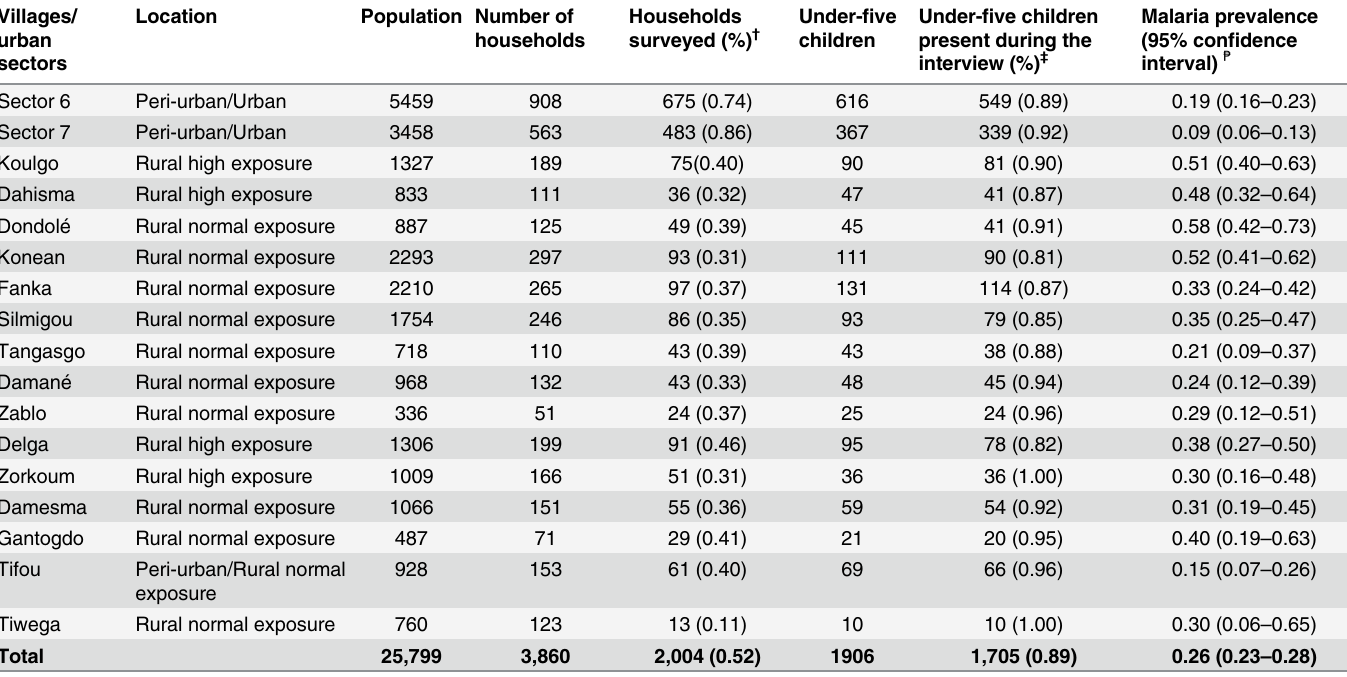
Table 1. Characteristics of villages and urban